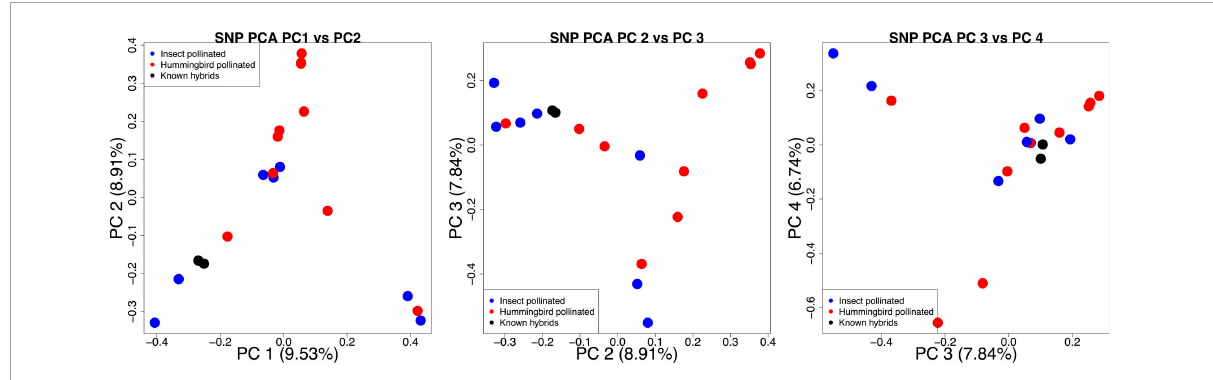
FIGURE8 Principal component analyses using the first four principal components. Accessions are color coded if they are bee pollinated (bee), bird pollinated (red), or are known hybrids (black).